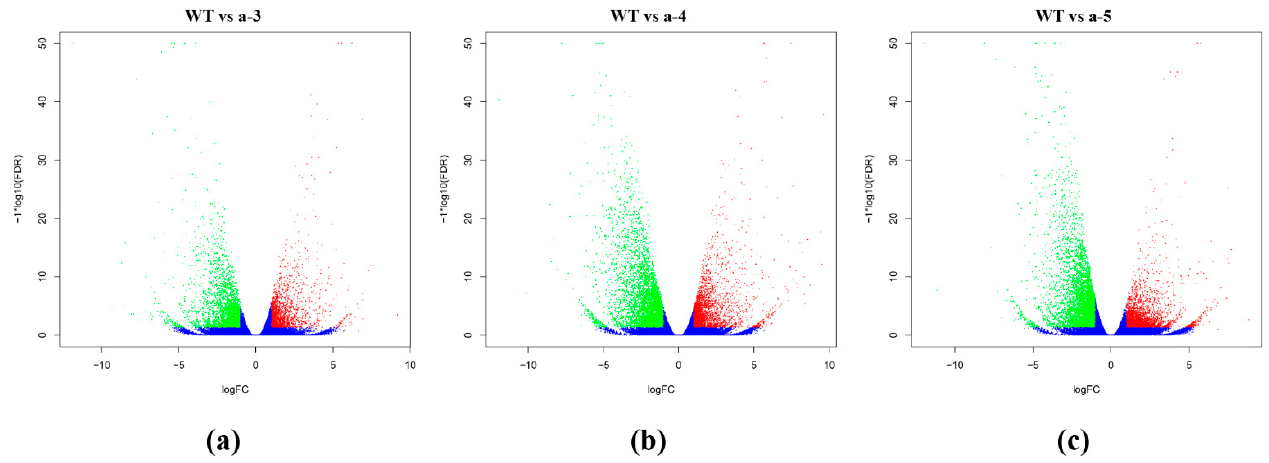
Figure 5. Volcano plots of differentially expressed genes (DEGs) among the wild-type (WT), a-3, a-4, and a-5 lines, based on transcriptomic analysis of L arix kaempferi . The plots compare gene expression between the WT and ( a ) a-3, ( b ) a-4, and ( c ) a-5. Upregulated DEGs in the upper right (red), downregulated DEGs in the upper left (green), and nondifferentially accumulated genes at the bottom (blue).